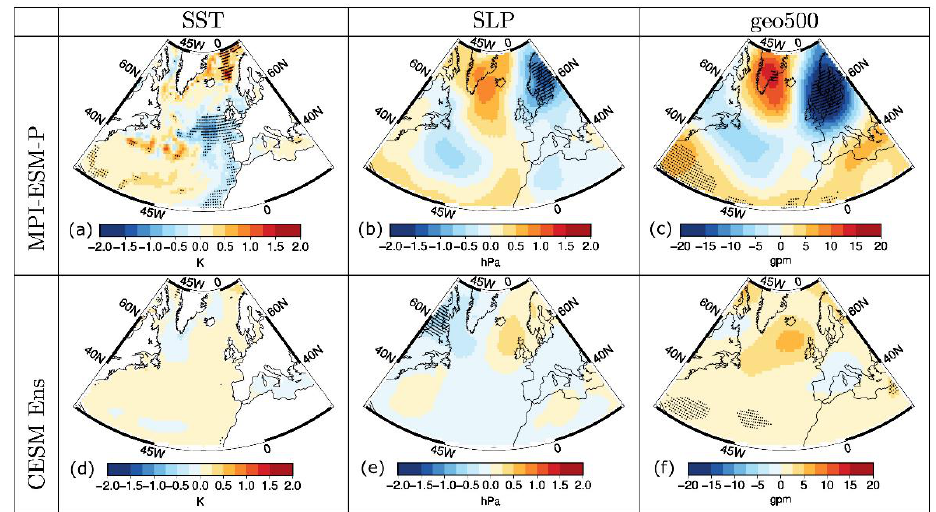
Figure 6. Composite patterns for high TSI minus low TSI periods for the SST ( a , d ), the SLP ( b , e ) and the geo500 ( c , f ) for the MPI-ESM-P ( a – c ) and CESM ensemble mean ( d – f ). The hatched areas indicate statistical significance at the 5% level.